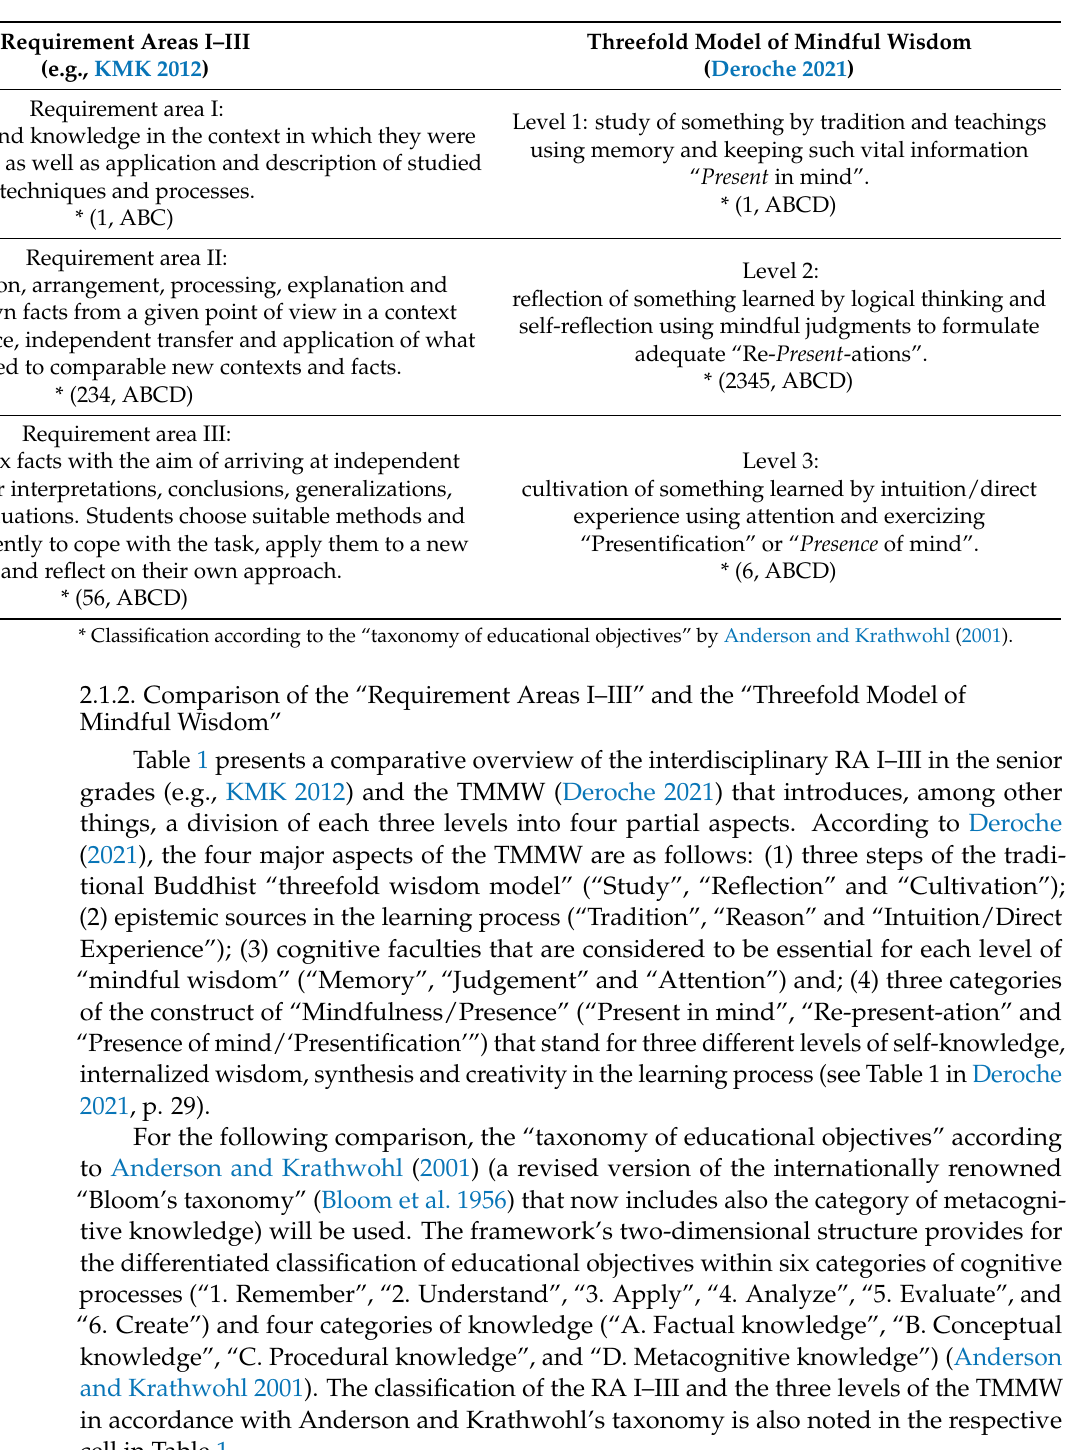
Table 1. Comparative overview of the interdisciplinary “requirement areas I–III” (according to, e.g., KMK (2012)) and the “Threefold model of mindful wisdom” (according to Deroche (2021),